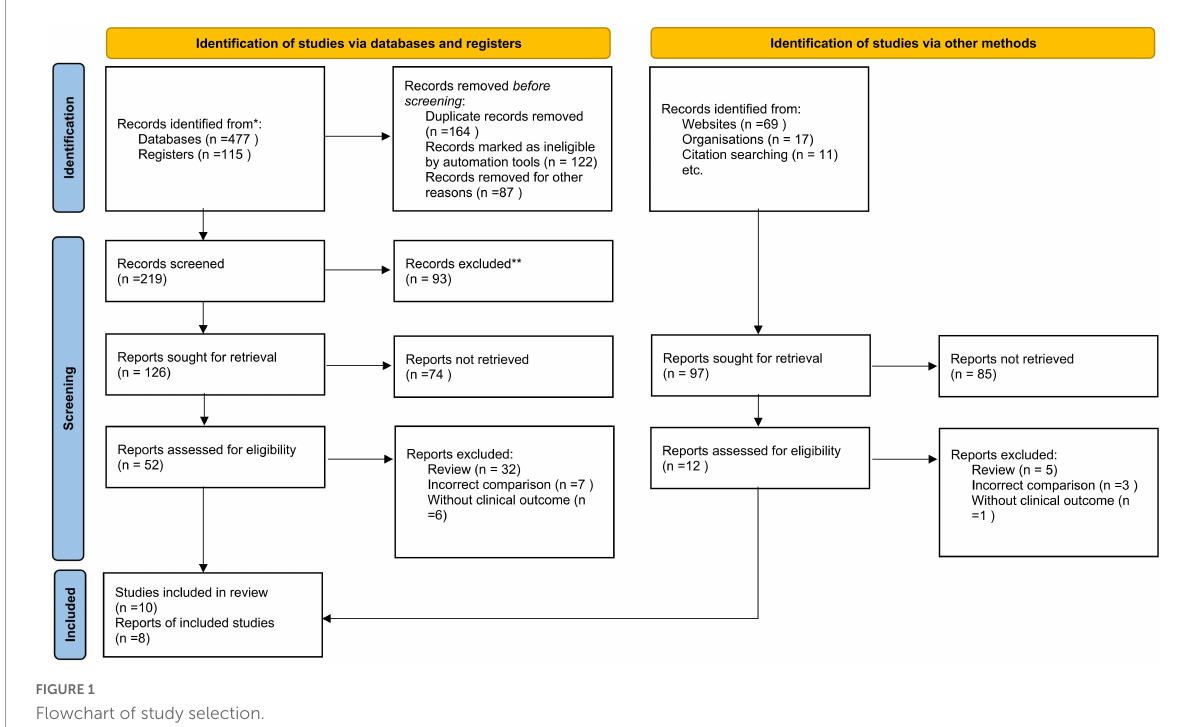
FIGURE1 Flowchart of study